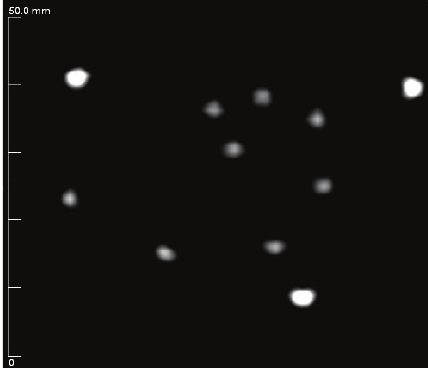
Figure 8: Speed-of-sound image of nautilus phantom showing 608- micron monofilament structures window leveled to show maximum contrast against a water background (grayscale in